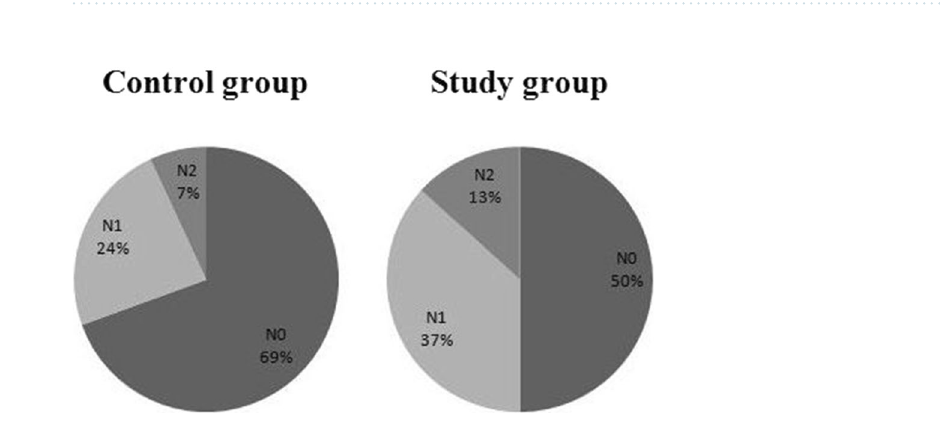
Figure 3. The constituent ratios of N0, N1, and N2 in study and control groups without statistic difference ( P =